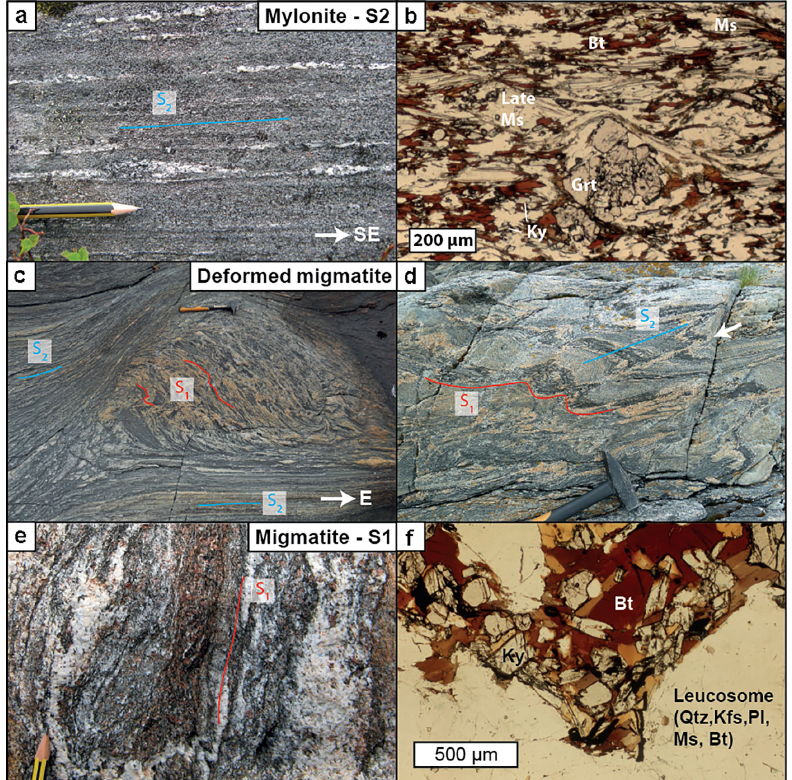
Figure 5. Field photographs and photomicrographs from the Nordmannvik Nappe. (a) Nordmannvik mylonite (solid-state deformed, S 2 , migmatite) at sample site AR26 near the Nordmannvik–Kåfjord boundary. (b) Photomicrograph of sample AR26 showing garnet porphyrob- lasts with sillimanite inclusions in a matrix and a strong S 2 foliation defined by biotite, kyanite, and muscovite. (c) A lens-shaped domain in the Nordmannvik Nappe on Uløya at lat 69.84046, long 20.51852 with an older S 1 migmatitic foliation overprinted and sheared by solid-state S 2 mylonitic foliation. (d) Nordmannvik migmatite at site AR23 showing the folded S 1 migmatitic foliation (Caledonian fold geometry) with a melt segregation in an axial planar orientation (white arrow; parallel to S 2 ). (e) Nordmannvik migmatite at sample site AR25b showing a high volume of leucosome and garnet- and biotite-rich melanosomes. (f) Photomicrograph of sample AR25b showing a lack of S 2 foliation, and kyanite and biotite along the edge of a leucosome